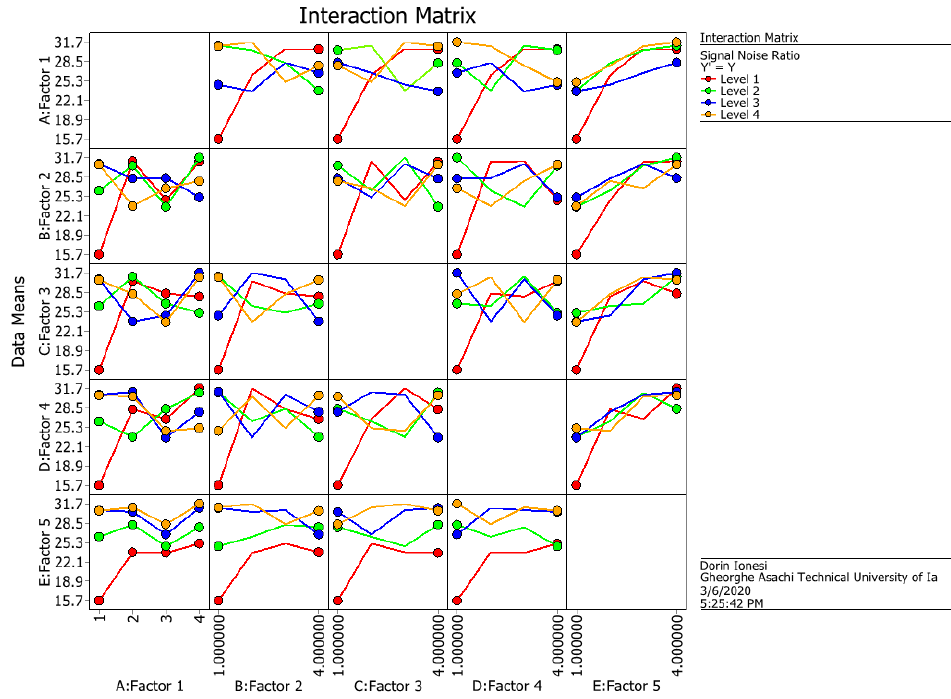
Figure 8. The interactions between factors for S/N ratio.